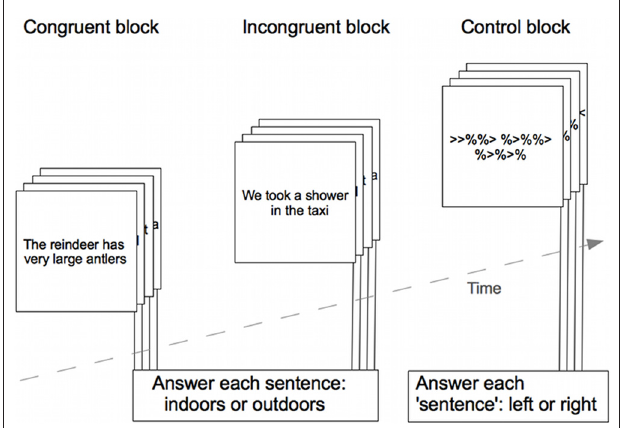
FIGURE 1 | Schematic outline of the paradigm used to assess semantic processing during fMRI. The figure shows one example trial from each condition block, the actual sentences were in Swedish. Responses were given during each trial